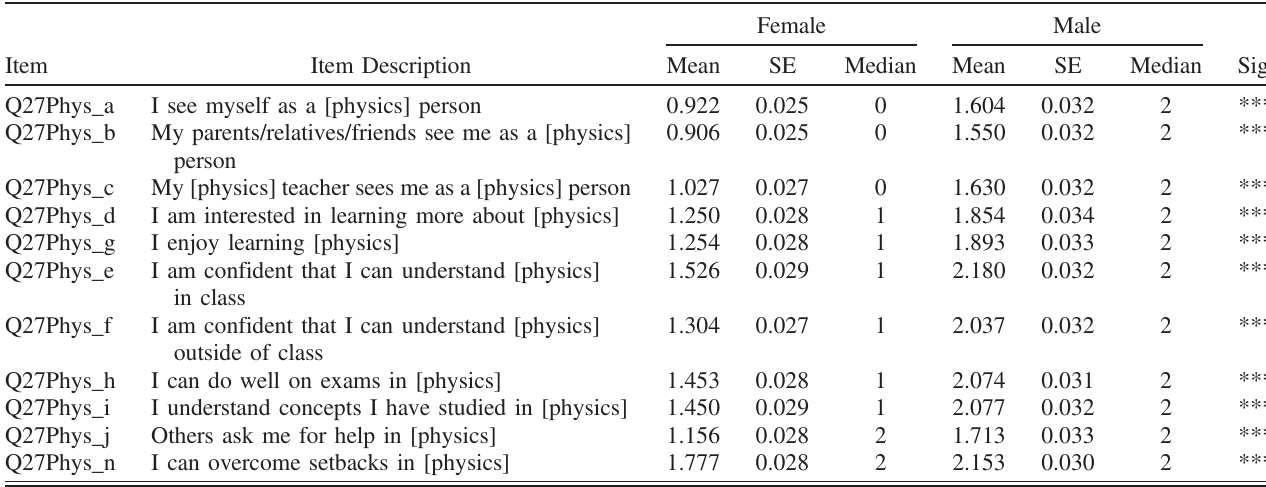
TABLE II. Wilcoxon tests for physics identity items. ***: p < 0 . 001 .